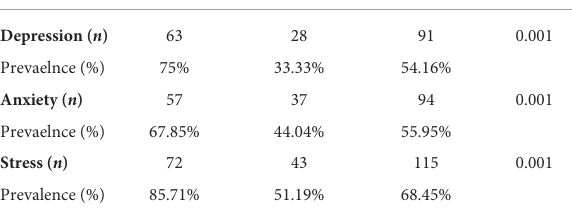
TABLE 2 Prevalence of depression, anxiety, and